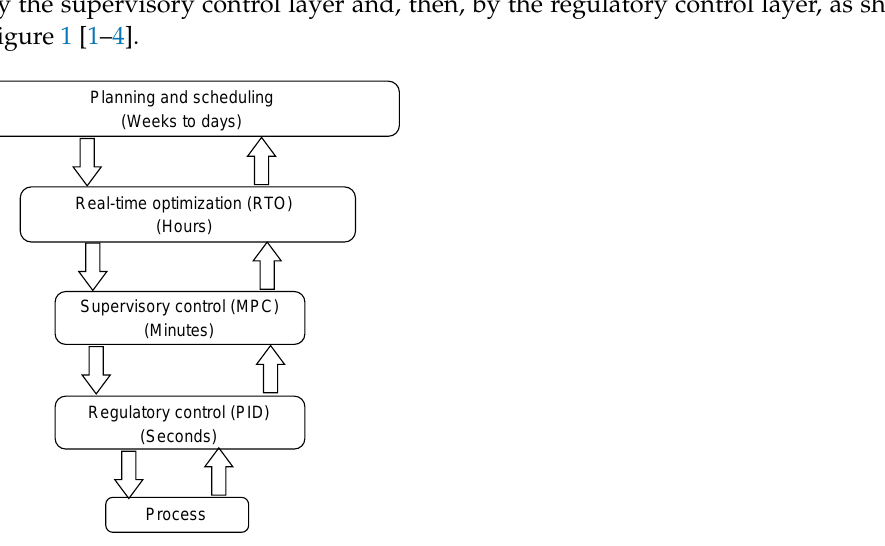
Figure 1. The typical control and optimization system hierarchy in